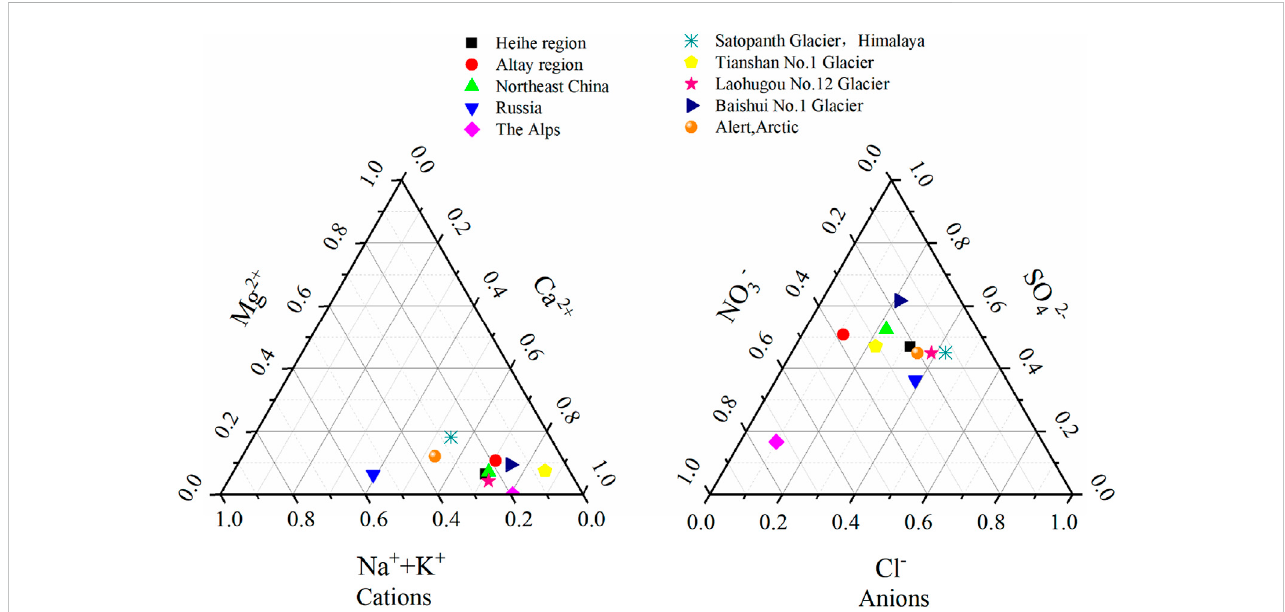
FIGURE 11 Relative proportions of anions and cations between the study area and other typical snow cover areas. Na + + K + , Ca 2+ , and Mg 2+ are selected as cations. NO 3 − , Cl − , and SO 4 2- are selected as anions.